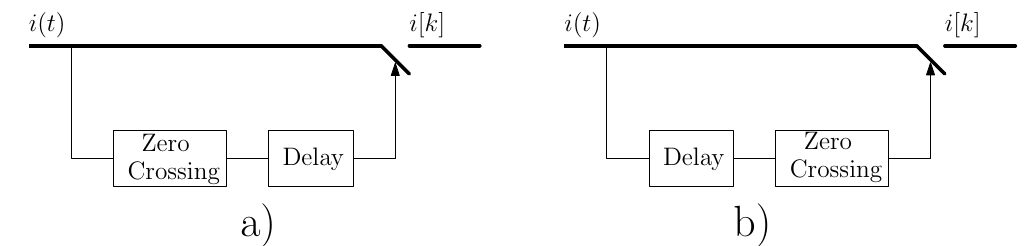
(cid:12) (cid:12) (cid:12) (cid:12) [ k ] (cid:12) . In ( a ) the (cid:12) i